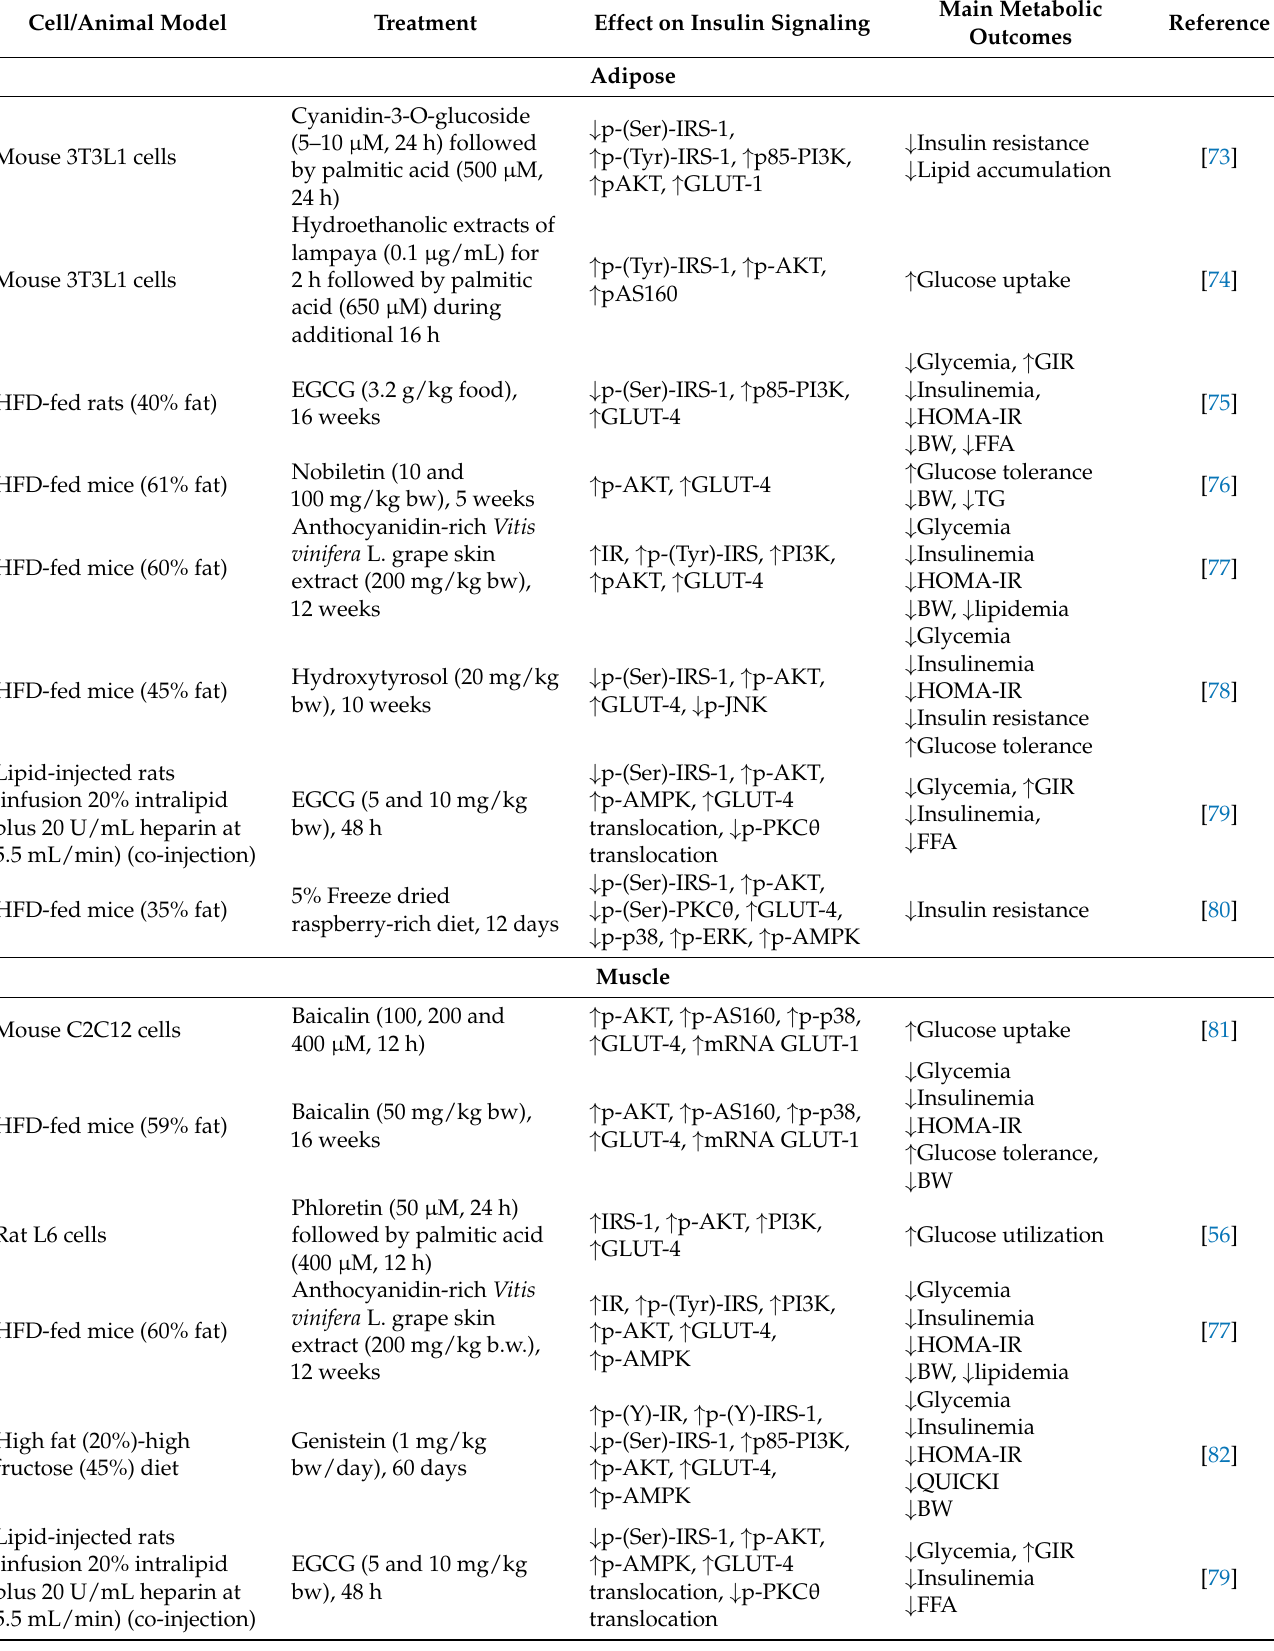
Table 4. Effects of flavonoids on insulin signaling in classical target tissues in obesity a